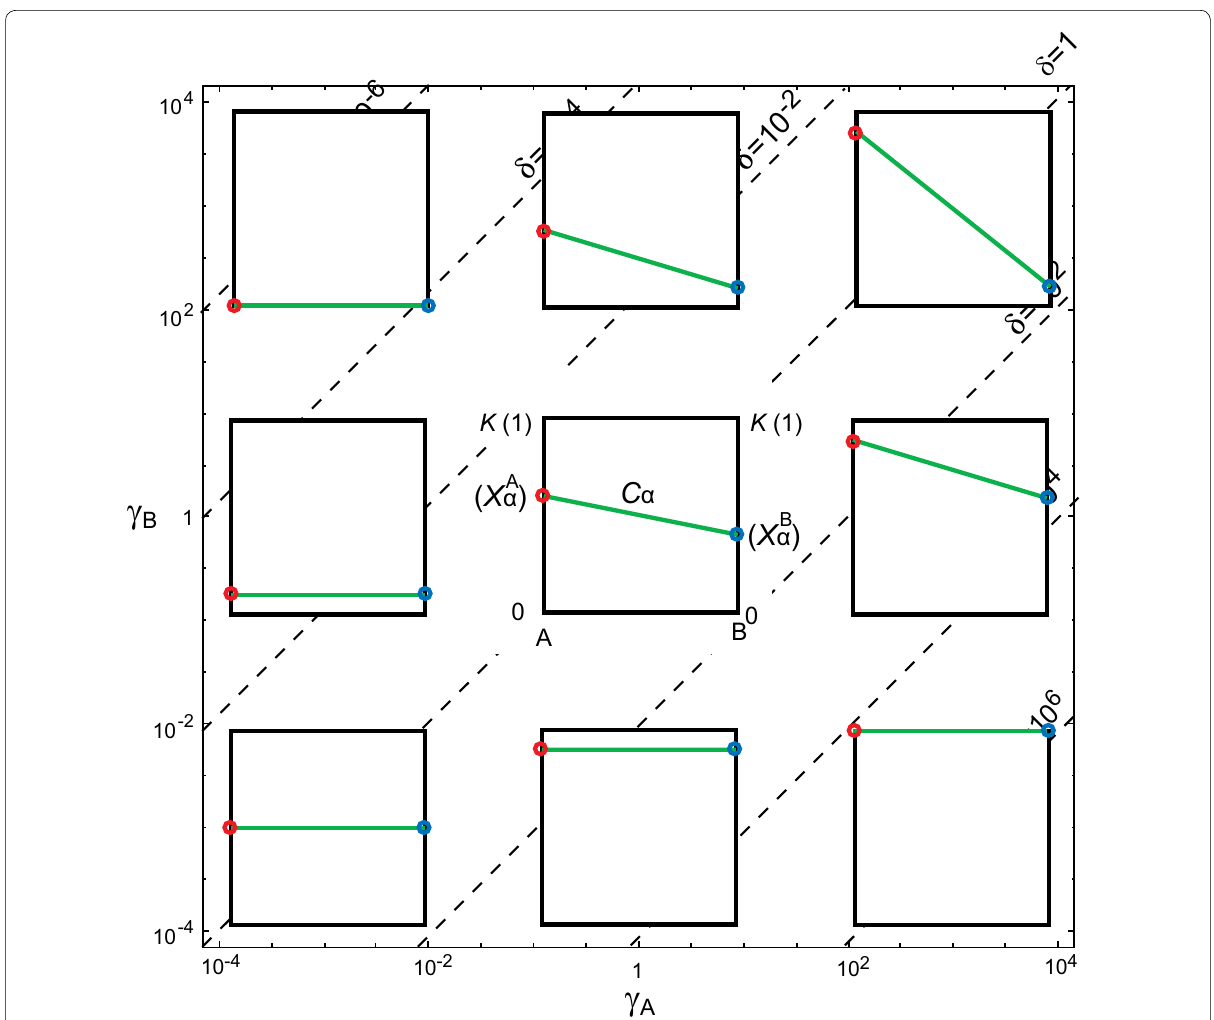
Fig. 3 The concentration profiles of the α component (green line) for various sets of the governing parameters γ A and γ B . The horizontal axis of each graph depicts the one-dimensional spatial coordinate of the modeling system, where minerals A and B occupy the left and right sides, respectively. The vertical axis is the concentration of the α component from zero to the coefficient of the equilibrium abundance ratio K . Because the concentration C α is linearly related to the mineral composition X α by Eq. (1), the values on each side of the graph correspond to the compositions of the precipitated mineral, where the scale of the vertical axis ranges from 0 to 1. The red and blue circles refer to X A α and X B α , respectively. The parameter set (γ A , γ B ) for each compositional profile is set to ( 10 − 2 ,10 2 ) , ( 1,10 2 ) , ( 10 2 ,10 2 ) ; ( 10 − 2 ,1 ) , (1, 1), ( 10 2 ,1 ) ; ( 10 − 2 ,10 − 2 ) , ( 1,10 − 2 ) , ( 10 2 ,10 − 2 ) , from left to right row by